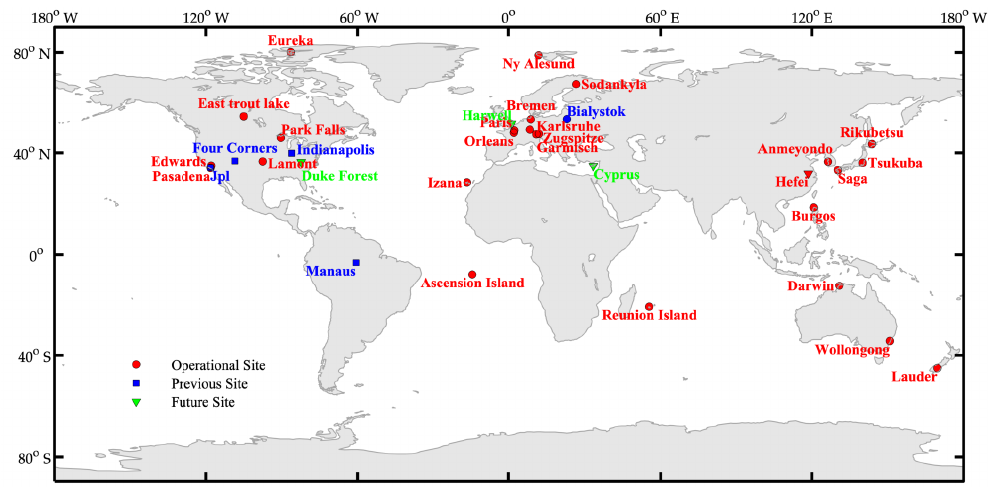
Figure 1. Locations of the operational, previous and potential TCCON